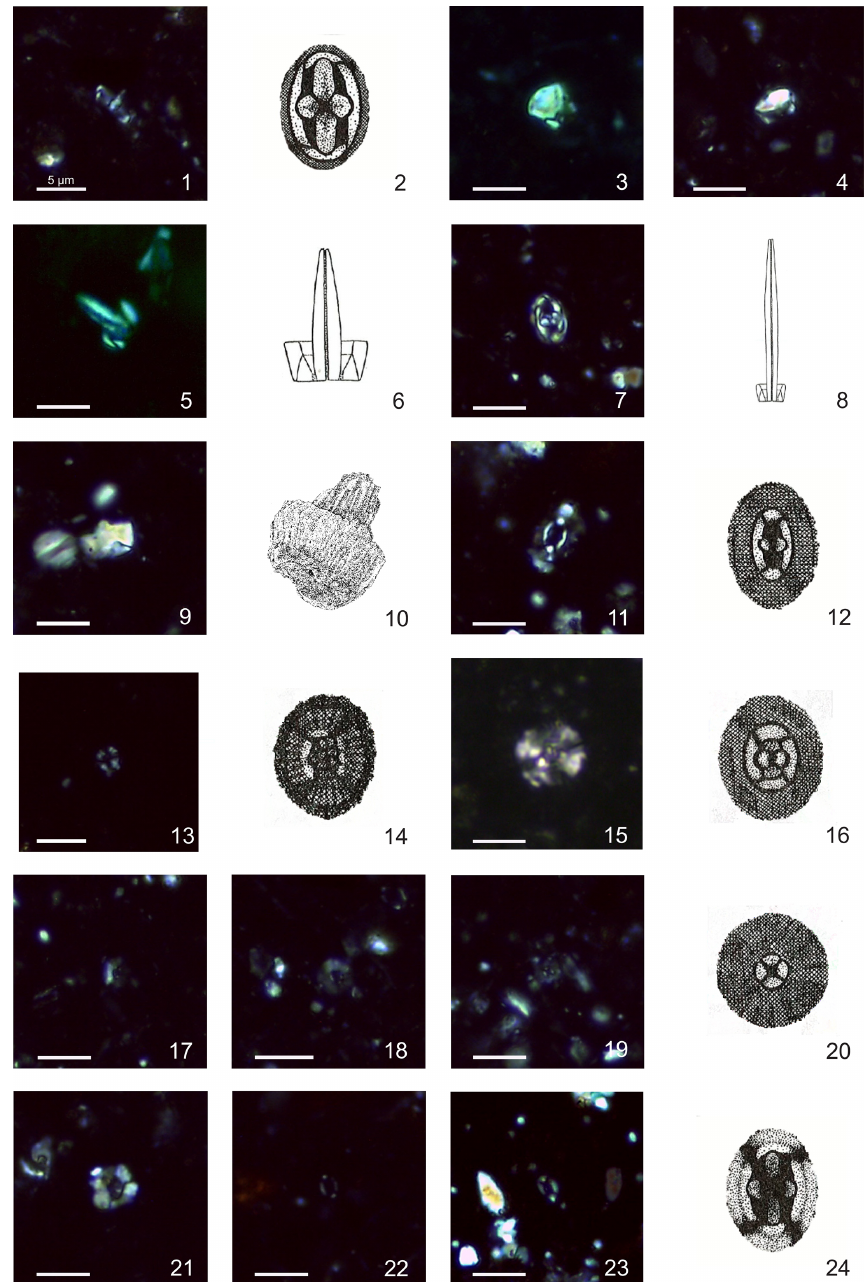
Plate 2. Calcareous nannofossils from El Matuasto I, Los Molles Formation, Neuquén Basin. All pictures from LM under crossed